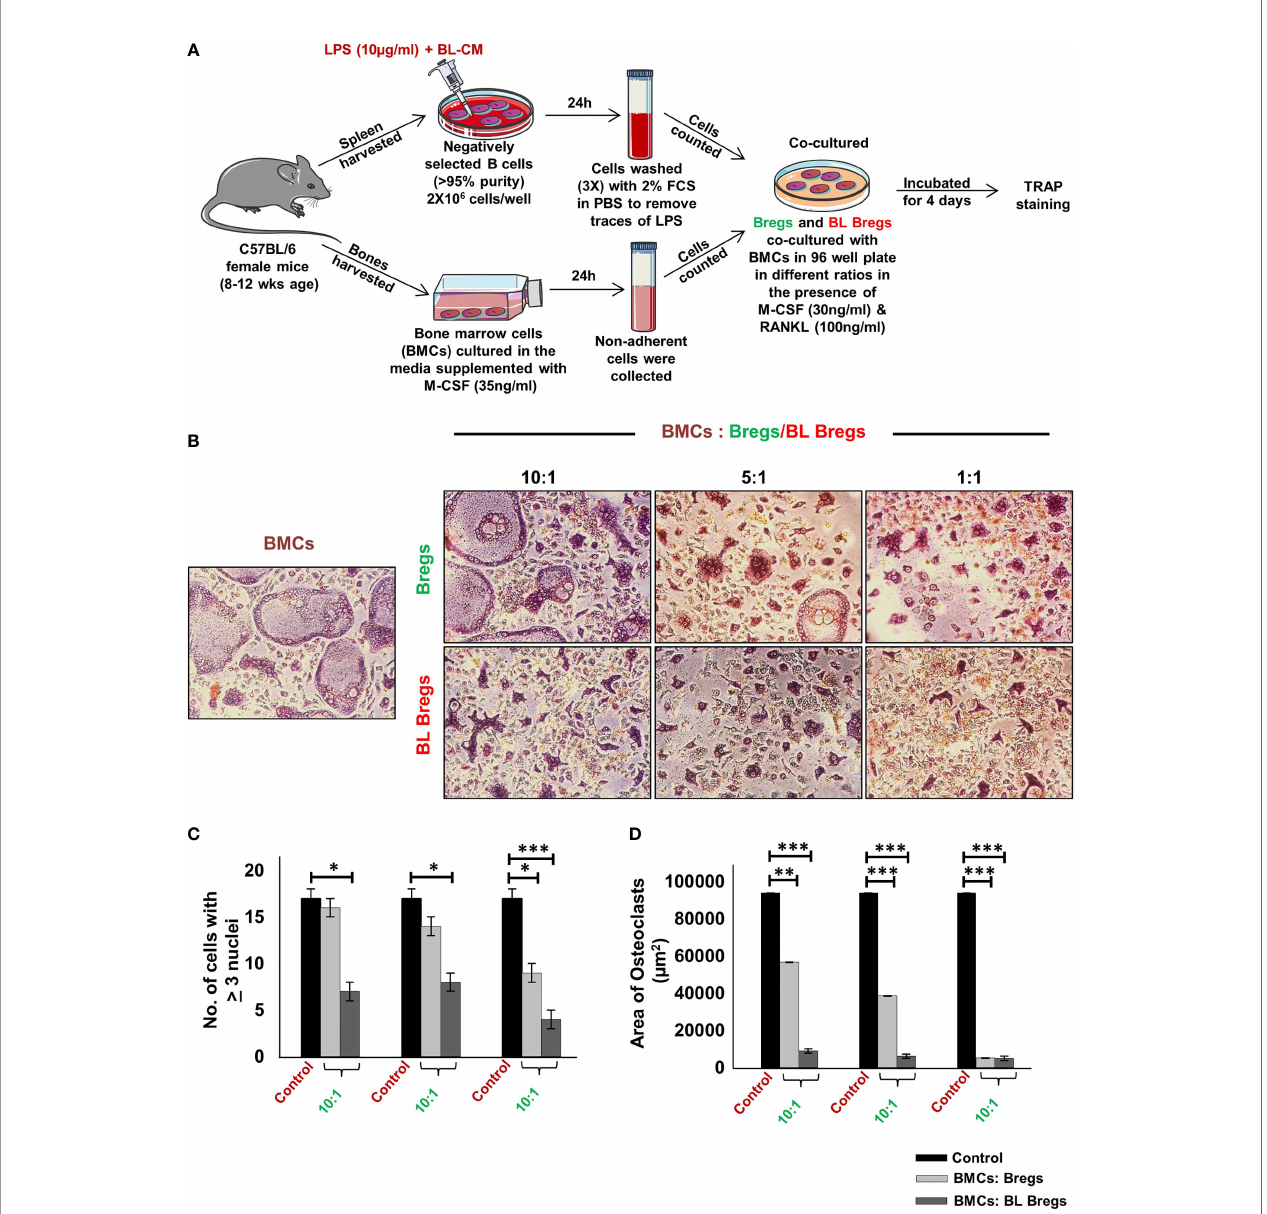
FIGURE 3 | BL enhances anti-osteoclastogenic potential of Bregs: (A) BMCs and LPS stimulated and LPS + BL-CM were cocultured in a cell culture plate in the presence of M-CSF (30 ng/ml) and RANKL (100 ng/ml) for 4 days. B cells were induced with LPS (10 µg/ml) and BL-CM (1:5) for 24 h prior to cocultures. (B) LPS + BL-CM-induced Bregs suppress osteoclastogenesis more ef fi ciently in comparison to LPS-induced Bregs. (C) Number of TRAP-positive cells with more than 3 nuclei. (D) Area of osteoclasts. The above images are indicative of one independent experiment, and similar results were obtained in at least three independent experiments (n ≥ 3). Statistical signi fi cance was considered as p ≤ 0.05 (*p ≤ 0.05, **p ≤ 0.01, ***p ≤ 0.001) with respect to indicated